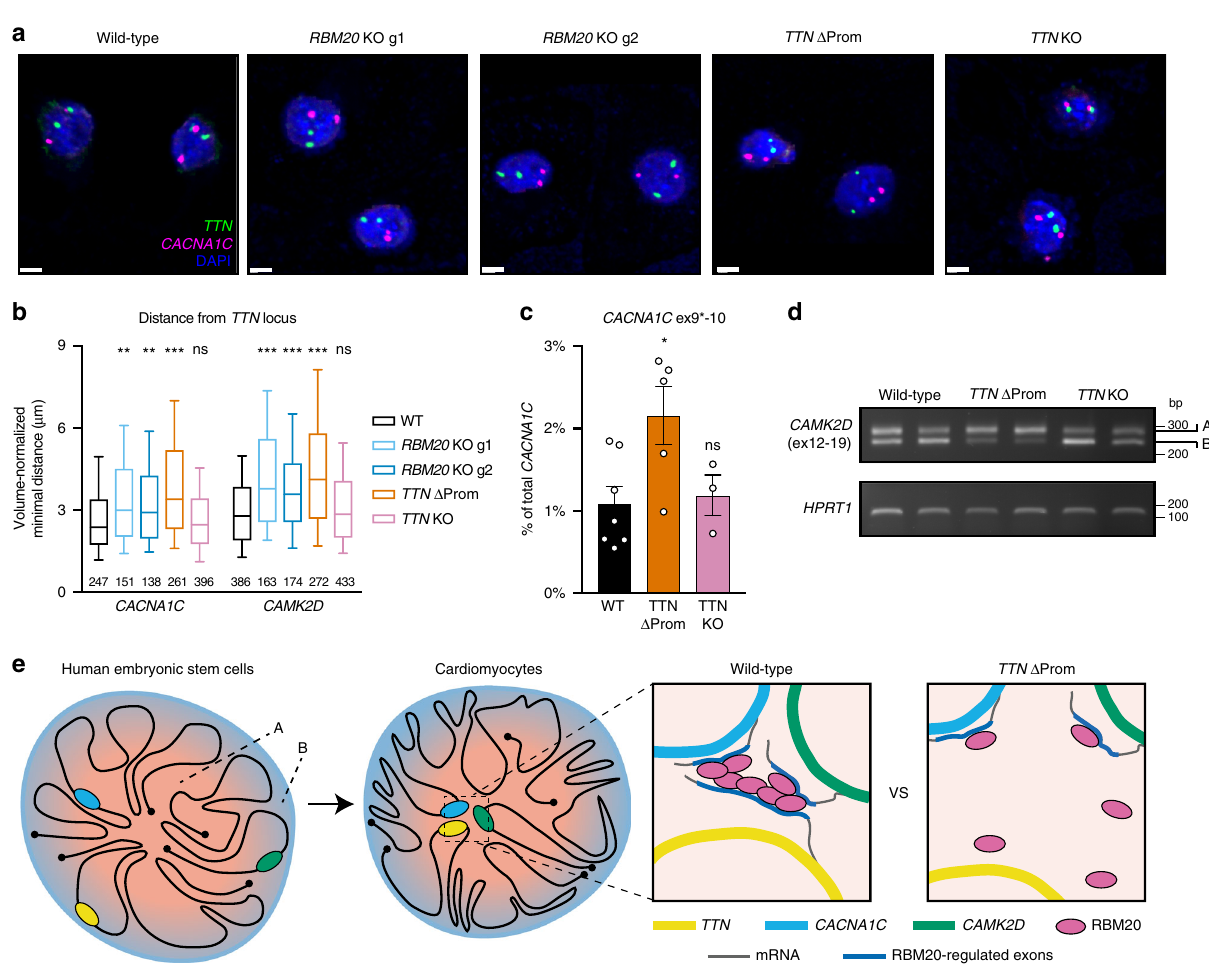
Fig. 10 RBM20 foci promote alternative splicing of genes interacting with TTN in trans . a Representative 3D DNA FISH images in CM derived from the indicated hESC lines (nuclei counterstained with DAPI); scale bars: 5 µ m. b Normalized minimum distance per diploid CM between TTN and the indicated loci (the number of cells is reported). Box and whiskers plots show median, 25th and 75th percentile, and the 10 – 90 percentile range. p -values by Kruskal – Wallis test followed by Dunn ’ s multiple comparisons vs WT; ns ≥ 0.05; ** < 0.01; *** < 0.001. c RT-qPCR in CM derived from the indicated hESC lines. Expression of the CACNA1C exon 9* isoform is relative to the total amount of CACNA1C and mean ± s.e.m. is shown. n = 3, 5, or 7 independent differentiations for TTN KO, TTN Δ Prom, and WT, respectively. p -values calculated by one-way ANOVA followed by Holm-Sidak ’ s multiple corrections vs WT; ns ≥ 0.05; * < 0.05. d Semiquantiative RT-PCR in CM for the indicated CAMK2D isoforms and the housekeeping gene HPRT1; n = 2